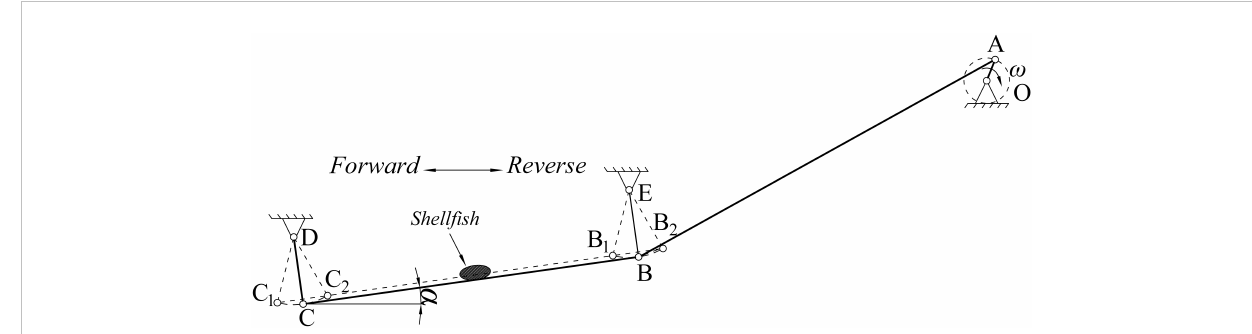
FIGURE 2 Vibrating screen mechanism diagram.